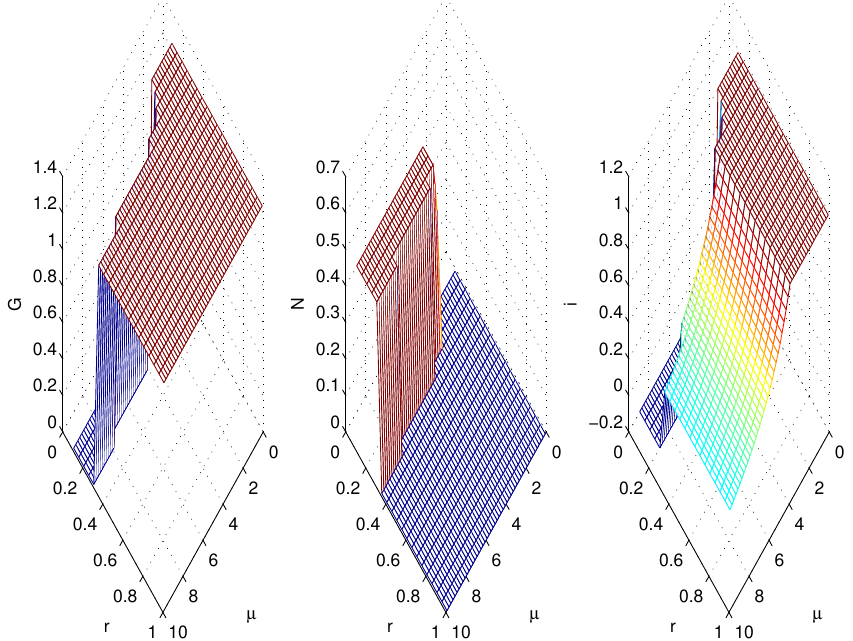
Figure 5. The ecosystem behavior as function of r and µ . The grey squirrel reproduction rate must fall really to low values to allow the survival of the native population together with the disappearance of both the disease and the invading species. Higher grey squirrel reproduction rates are allowed if the red squirrels’ natural plus disease-related mortality becomes